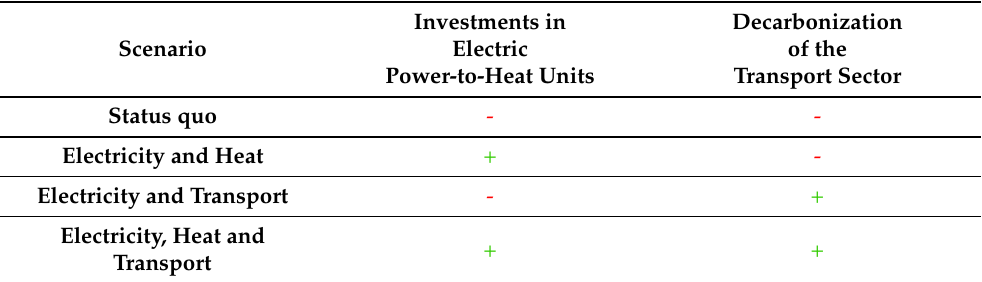
Table 3. Scenarios of this paper. “-” means not included, and “+” included. Scenario